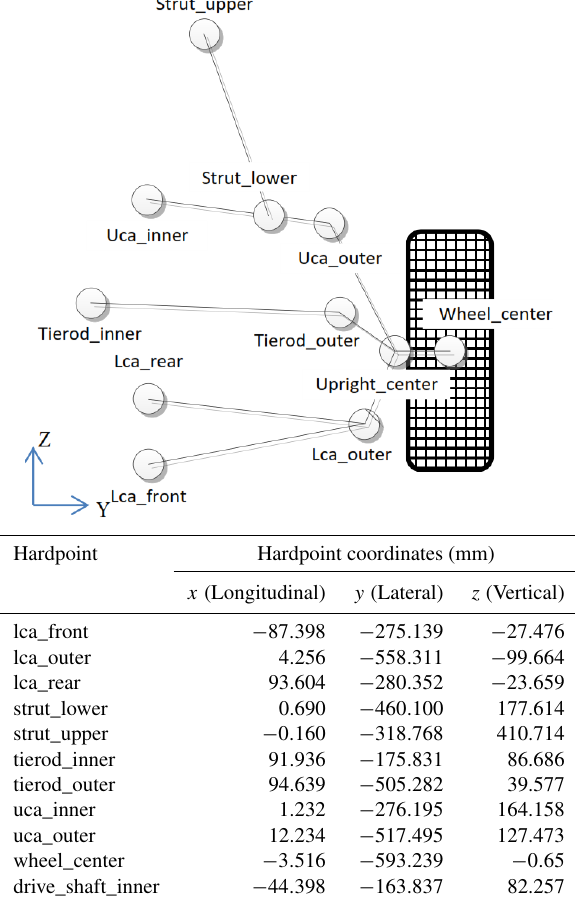
Table 3. Hardpoint coordinates of left front suspension.